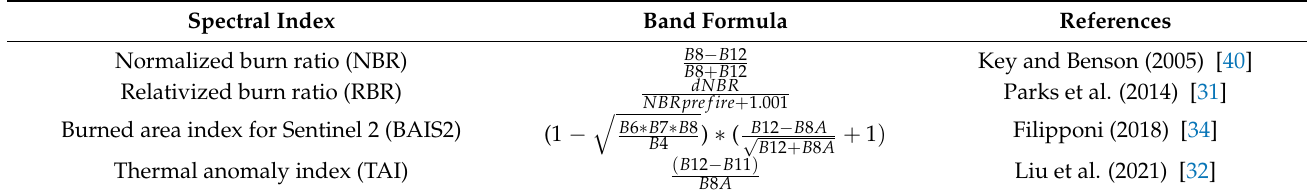
Table 4. List of spectral indices used in this